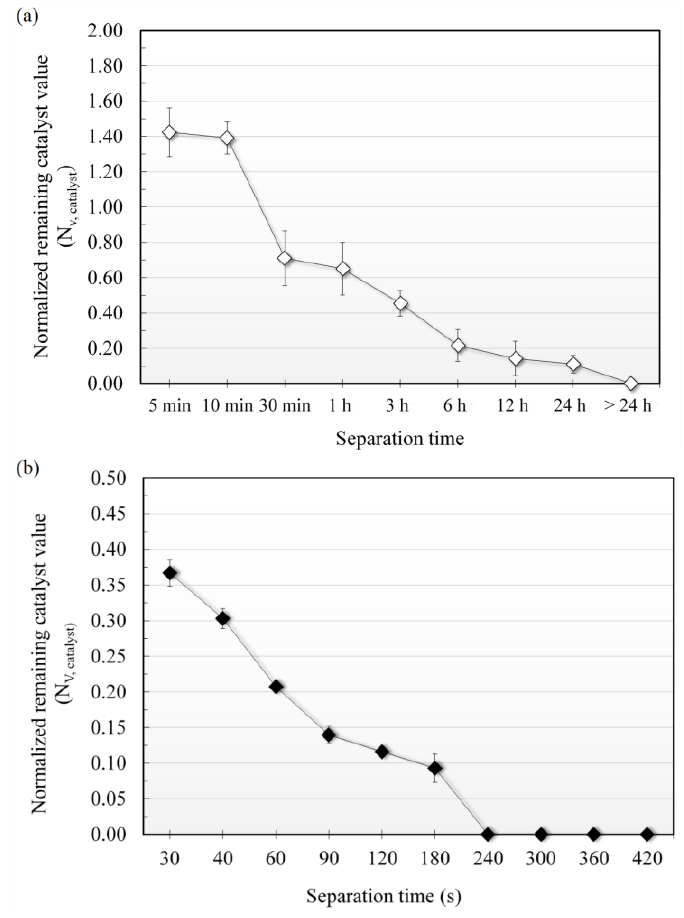
Figure 15. Normalized concentrations of remaining catalyst in the biodiesel final product from the EDS process using iron (Fe) point-to-point electrodes, with a vertical distance between electrodes of 3 cm and applied AC voltage of 3 kV: ( a ) gravitational settling (GS) and ( b ) electrically driven sepa- ration (EDS)